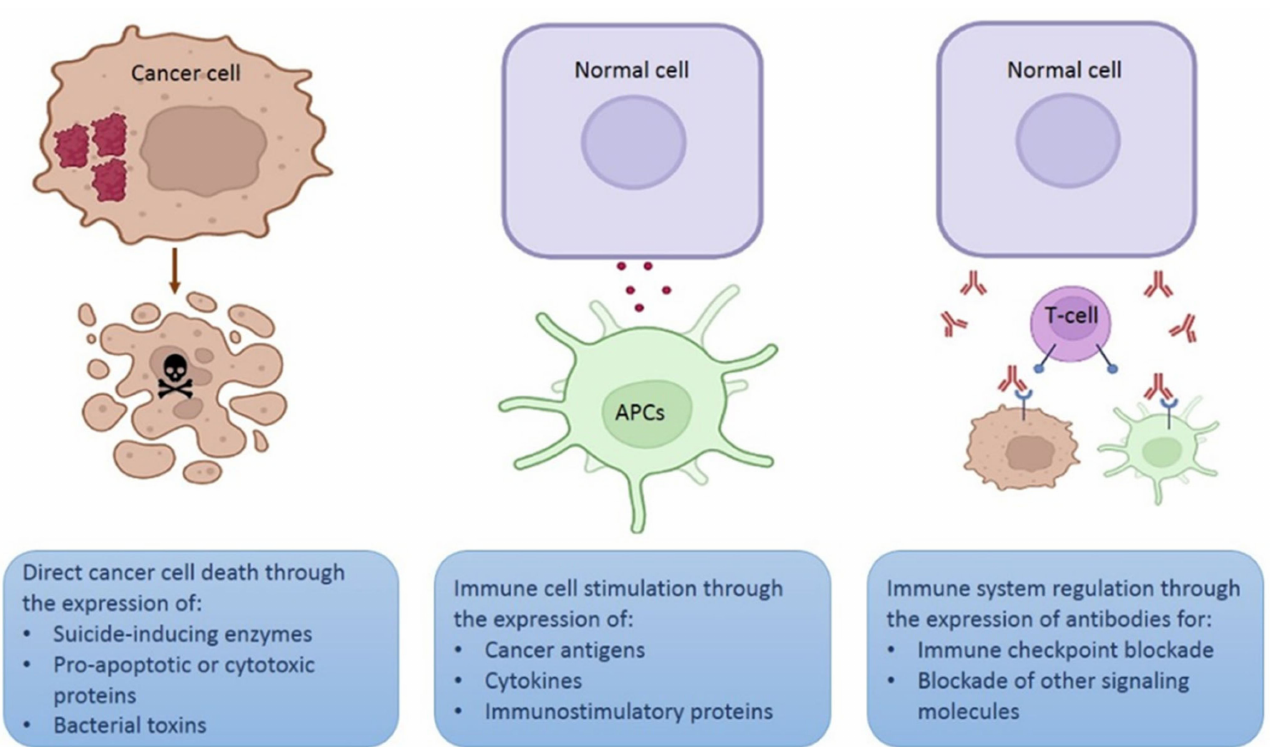
Figure 3. Different strategies using plasmids for therapeutic purposes. Schematic representation of three different strategies involving in vivo expression of therapeutic proteins. Figure created in